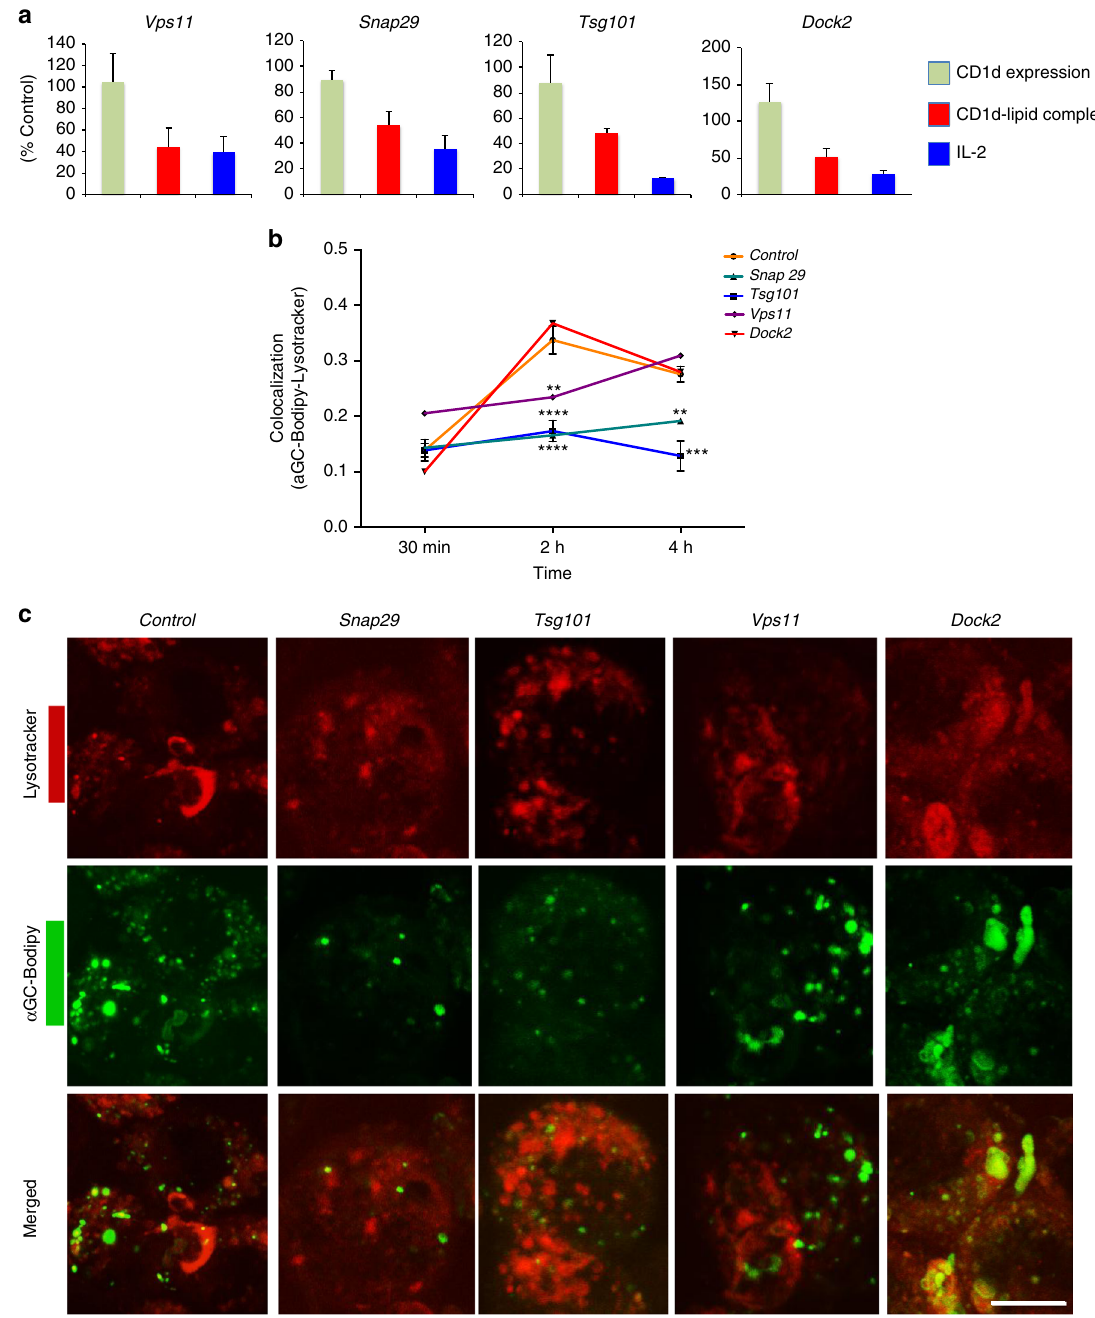
Fig. 5 Effects on lipid antigen uptake to lysosomes. a Comparative plots of normalized values for CD1d expression, CD1d-lipid complex formation by fl ow cytometry, and IL-2 release as described above for indicated genes. b Labeled antigen uptake. APCs with the indicated genes knocked down were incubated with α GalCer-Bodipy for the indicated times and LysoTracker added for a 2 h chase. Figure represents the co-localization coef fi cient. Representative data from one of two experiments in which at least 100 cells per time-point were analyzed. Nonsigni fi cant p -values are not indicated. c Representative images for α GalCer-Bodipy and LysoTracker at 2 h time-point. Scale bar 10 μ m. Graphs represent mean ± SD. ** p < 0.01; *** p < 0.001; **** p < 0.0001